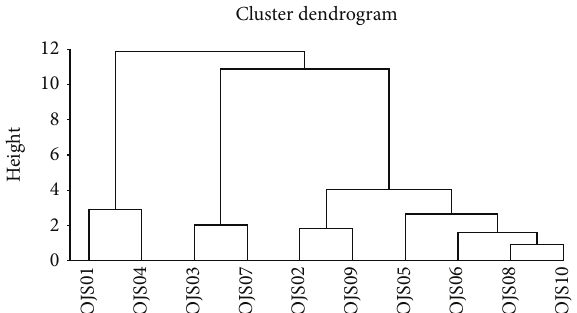
Figure5:DendrogramofthehierarchicalclusteringofOJSsamples. OJS01, Ojeok-san water extract from the laboratory; OJS02–OJS10, Ojeok-san granules from Korean